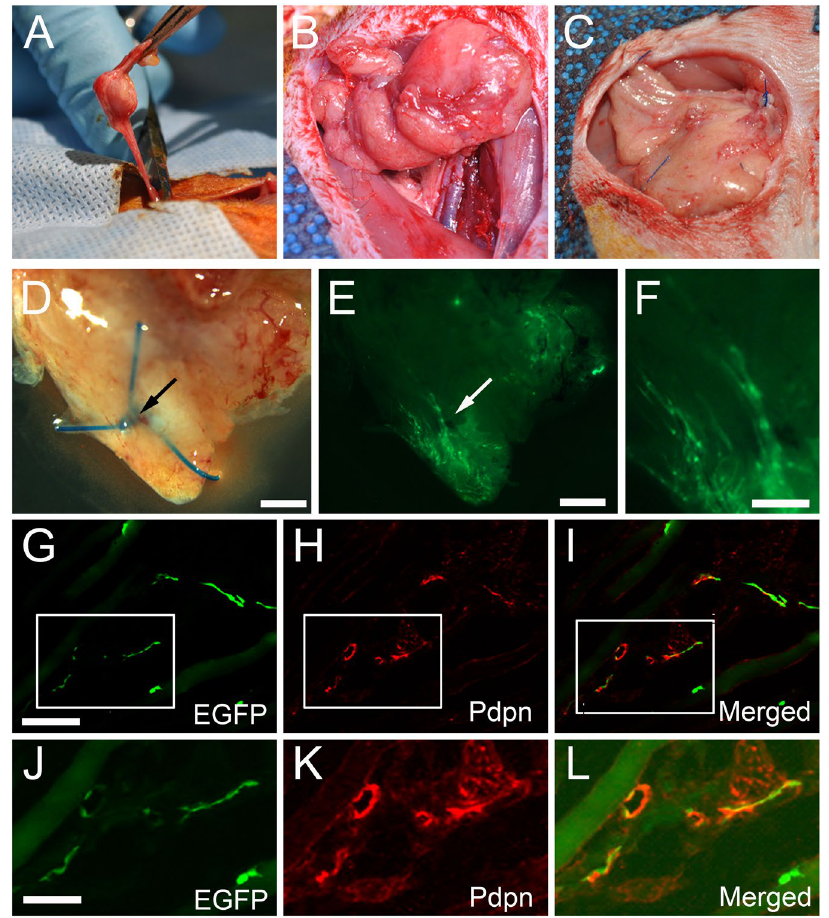
Figure 5. Visualization of host lymphatic contribution in vascularized lymph node transfer model. ( A ) Superficial inferior epigastric artery (SIEA) free flaps were isolated from EGFP − wild type Sprague-Dawley rats on a single vascular pedicle. ( B ) SIEA flap after transfer to a Prox1-EGFP recipient rat and completion of microsurgical anastomosis of the artery and vein. ( C ) Inset of the SIEA free flap using Prolene sutures, which facilitate identification upon harvest. ( D ) Gross appearance under a stereoscope of SIEA flap harvested after 30 days. Blue suture knot (arrow) marks the host-donor boundary. ( E ) EGFP signal at the inferior pole of the transferred flap at low magnification. ( F ) Enlarged image of the edge area demonstrating lymphatic vessels with EGFP + host-derived LECs. ( G–I ) Pdpn immunofluorescence assay identified host contribution to lymphangiogenesis in the donor tissue. ( J–L ) Enlarged images of boxed areas in panels ( G – I ), respectively. Scale bars: 1 mm ( D,E ), 0.5 mm ( F ), 100 µ m ( G ), 50 µ m ( J